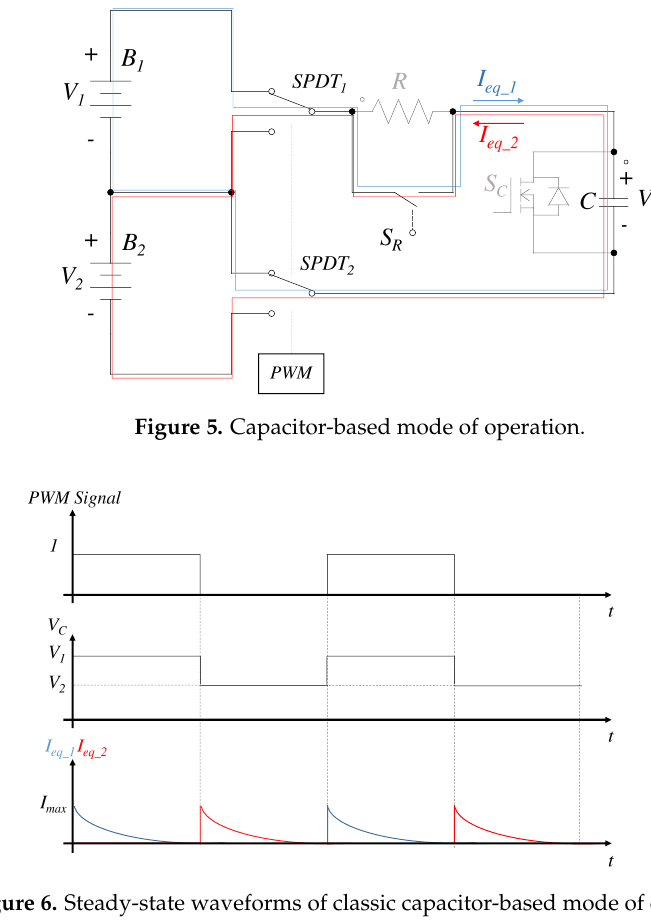
Figure 6. Steady-state waveforms of classic capacitor-based mode of operation.